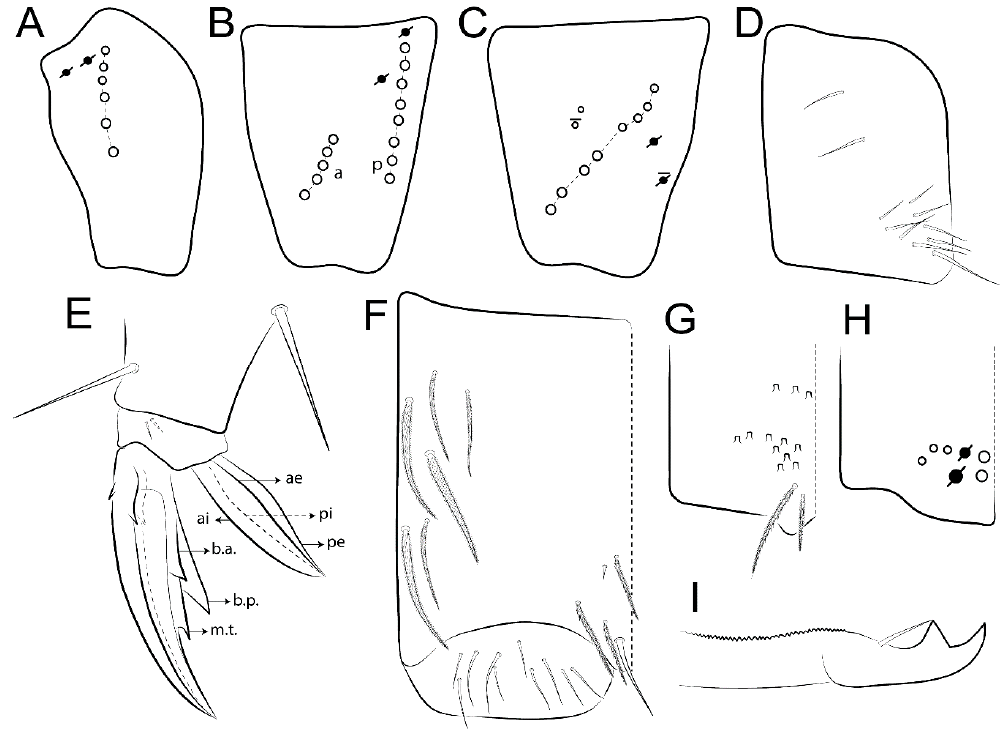
Figure 71. Pseudosinella macrolignicephala sp. nov. ( A–C ) subcoxa I–III, respectively; ( D ) trochanteral organ; ( E ) distal tibiotarsus and empodial complex III (anterior view); ( F ) collophore (lateral view); ( G ) distal part of manubrium (ventral view); ( H ) manubrial plate (dorsal view); ( I ) distal dens and mucro (outer view).